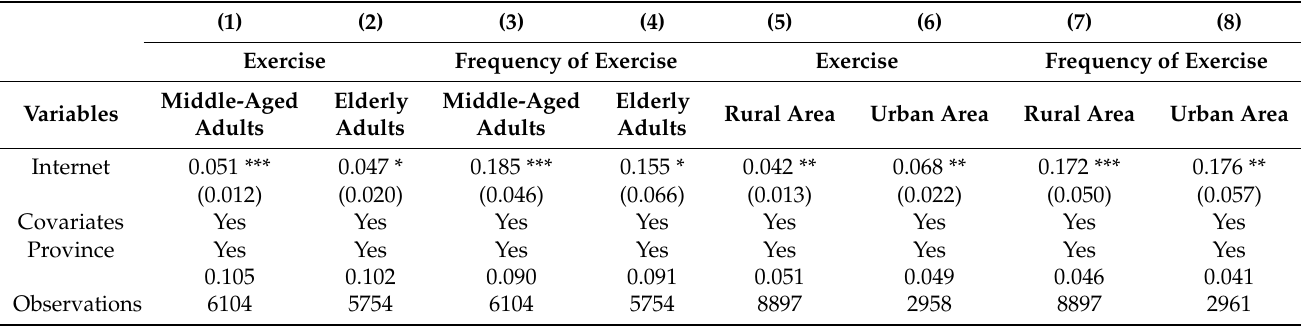
Table 5. Intergenerational and urban–rural differences in the association between Internet use and physical